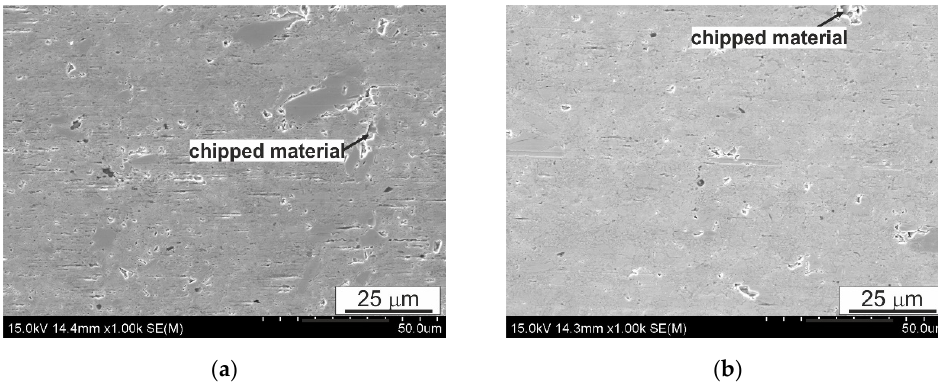
Figure 14. Characteristic sample surface of B89 alloy (FSP 560 RPM) after tribological tests in lubricated friction, ( a ) 10,000 m, ( b ) start-stop 10 × 1000 m; SEM.